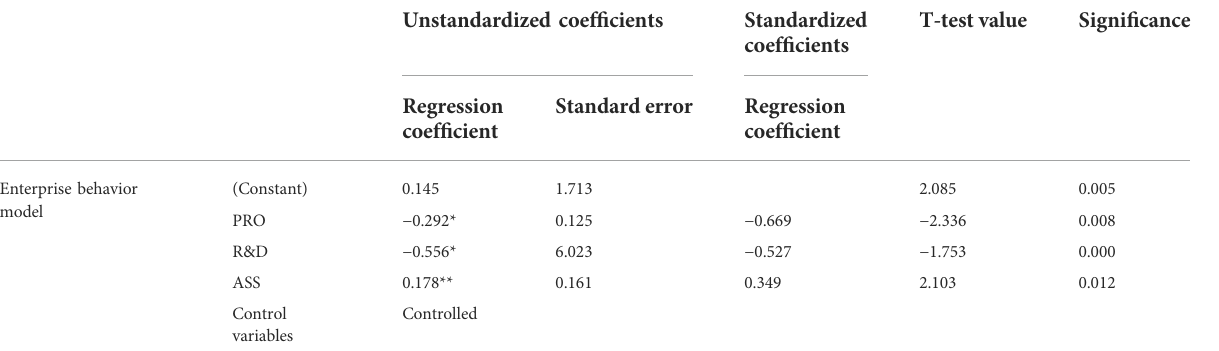
TABLE 5 Multiple regression coef fi cients of enterprise behavior